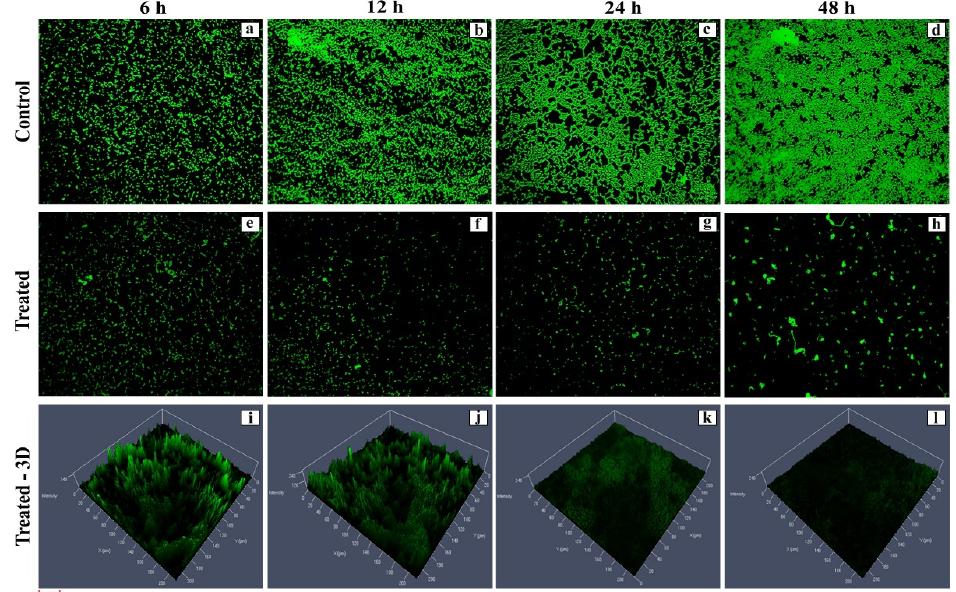
Figure 3. CLSM image of biofilm inhibition efficiency provided by the HPAEtOAc crude extract on MRSA cells at 6, 12, 14, and 48 h: ( a – d ) control; ( e – h ) treated; ( i – l ) treated 3D view.